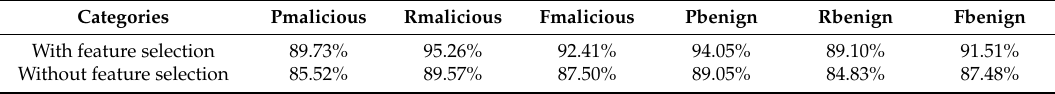
Table 4. The average classification results of 100 independently repeated